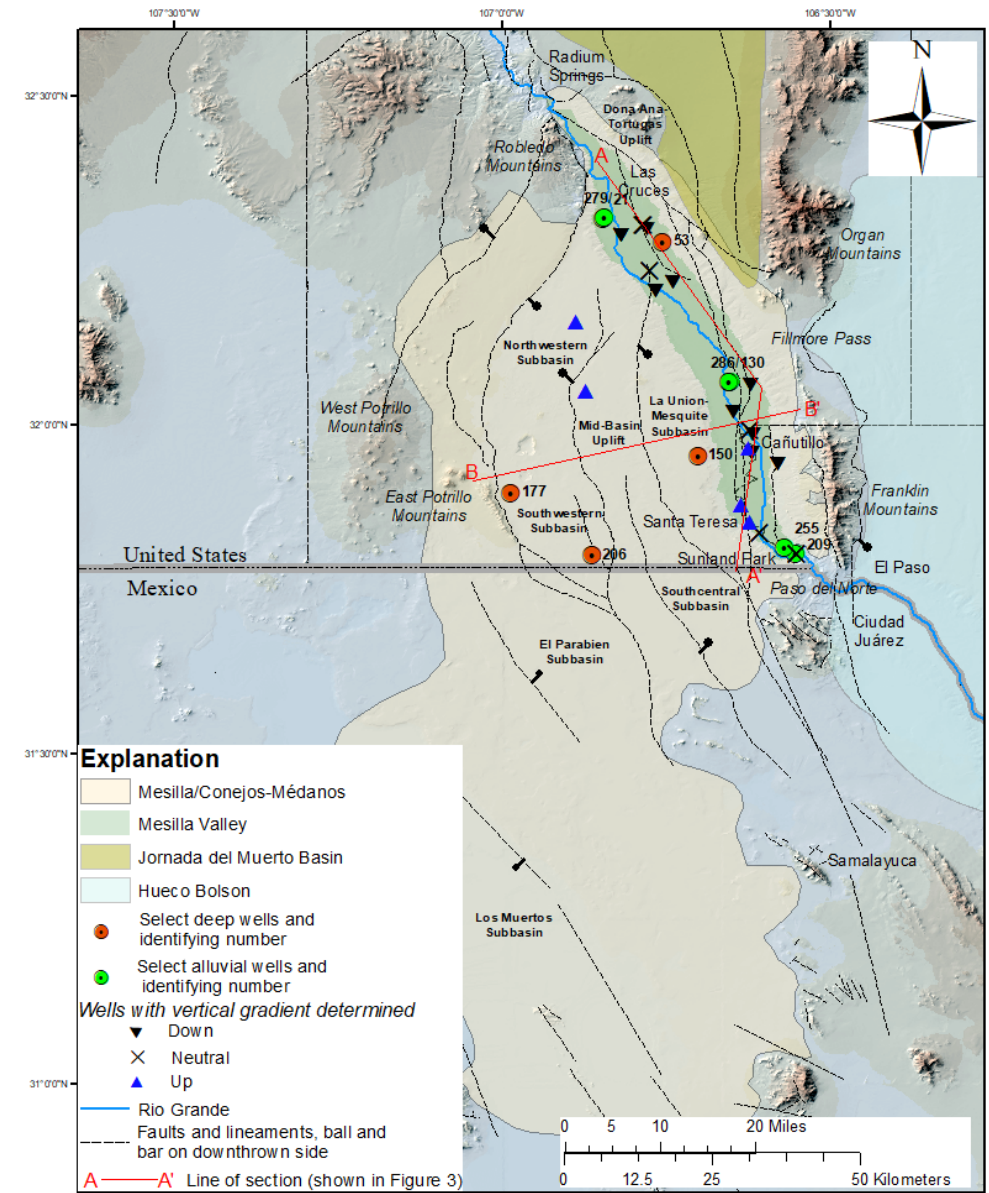
Figure 2. Major faults and structural features of the Mesilla/Conejos-Médanos Basin. Also included are the locations of nested wells, where vertical gradients have been determined, and select deep and shallow wells with long-term groundwater-level records. Base terrain and geographic references are from [5,6,34]. Coordinates are the geographic coordinate system relative to the North American Datum of 1983.